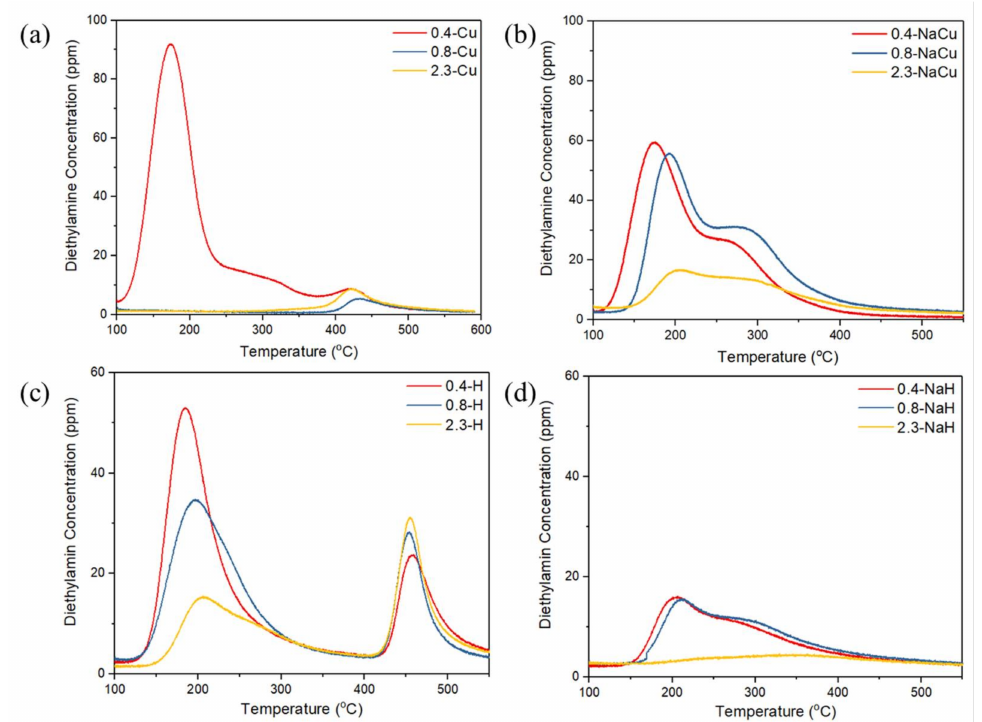
Figure 7. Diethylamine-TPD profiles of Cu/SSZ-13 ( a , b ) and H/SSZ-13 ( c , d ) before and after Na poisoning.